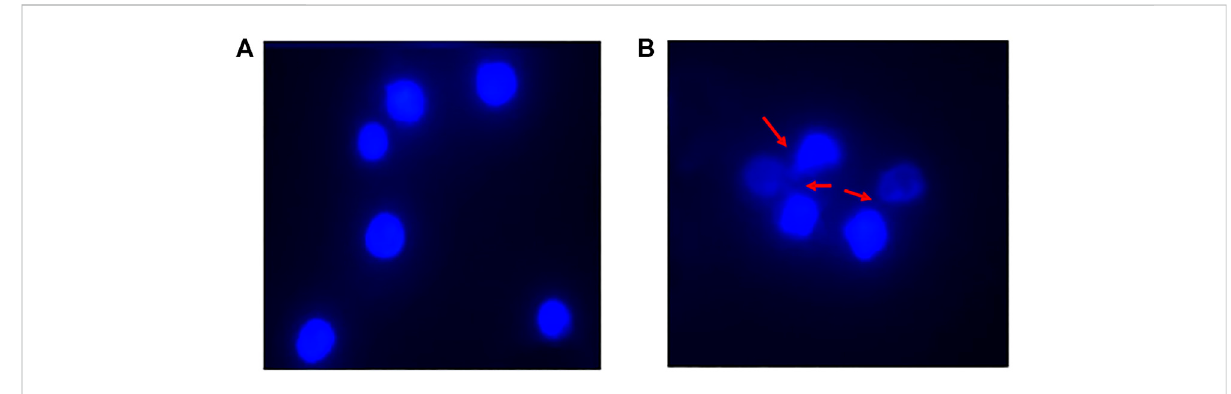
FIGURE 12 DAPIstained fl uorescentimagesof (A) NativeHSA (B) 4-Cl-OPDmodi fi